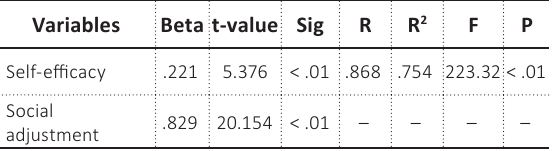
Table 3. Summary of multiple regression showing the joint and independent influence of age,